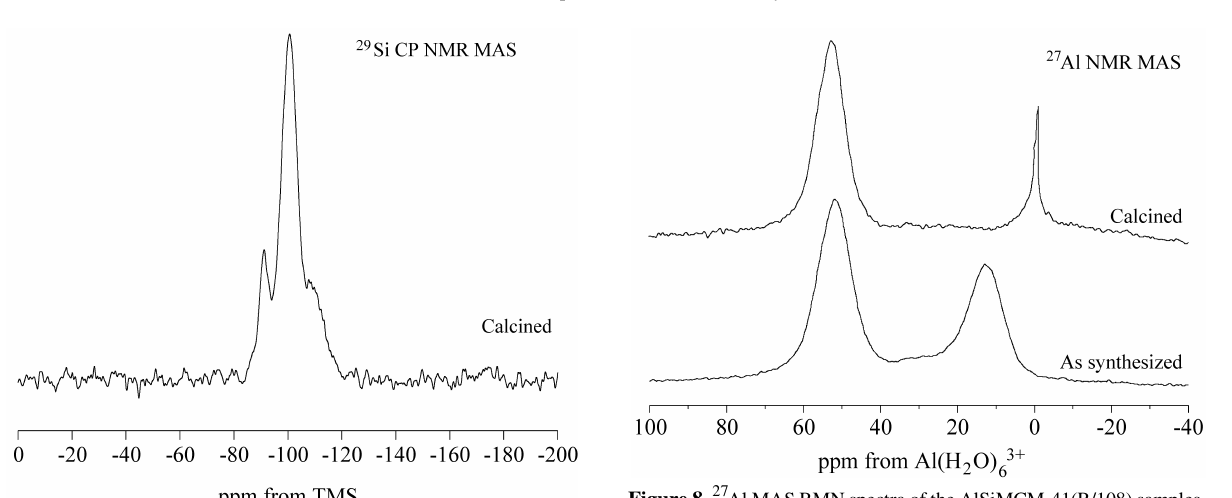
Figure 8. 27 Al MAS RMN spectra of the AlSiMCM-41(R/108) samples.